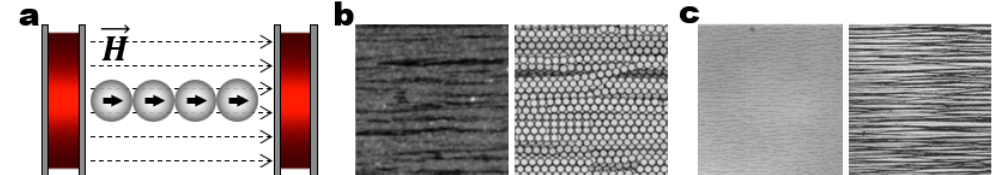
Figure 8. Field-driven dynamic structuring in a uniaxial magnetic electric field. ( a ) Schematic of the experimental setup for a unidirectional magnetic field. Upon application of the field, dispersed particles self-assemble into linear chains aligned parallel in the field direction. ( b ) Experimental (left) and simulation (right) results illustrating the chain-like structures assembled along the field direction. Fe particles of size 4 µ m were used in the experiment. Reproduced with permission [60]. Copyright 2000, American Physical Society. ( c ) Structural evolution in the assembly of 1.5 µ m superparamagnetic particles. (left) Assembly of scatter linear chains at low volume fraction. (right) Emergence of fibrous structures as a result of growth and coalescence of the chains at high volume fraction. Reproduced with permission [61]. Copyright 1992, Elsevier.